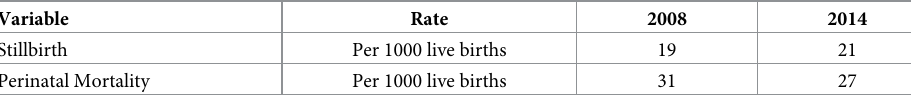
Table 6. Estimated stillbirth and perinatal mortality rates.